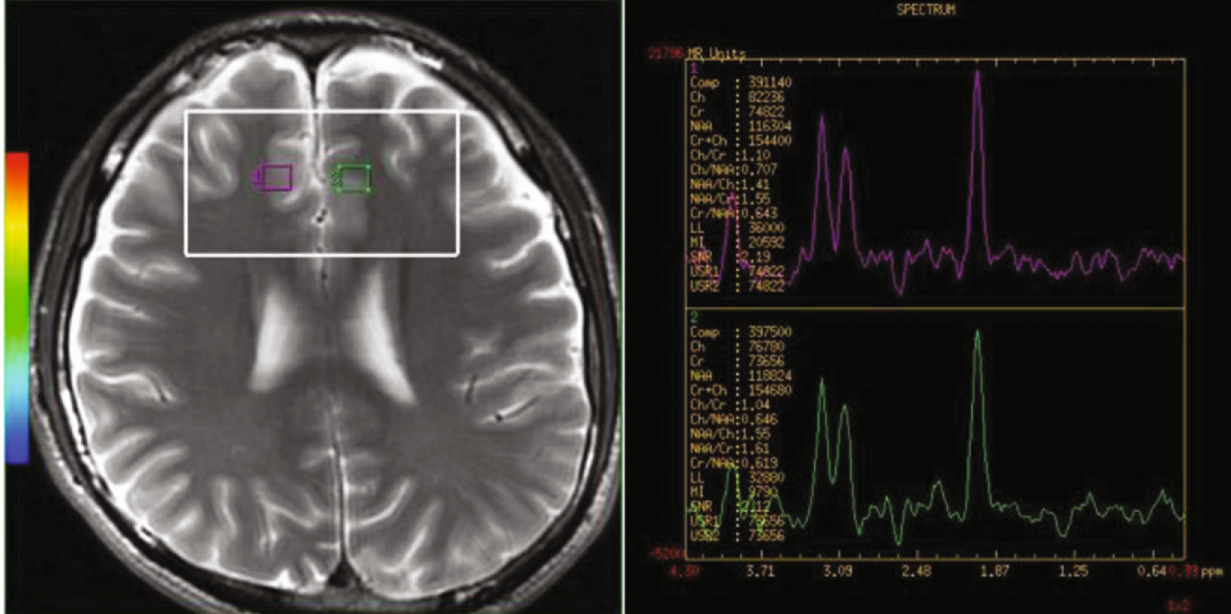
Figure 1: MRI showing the location of MRS of a VOI placed in the prefrontal cortex, with 1 H-MRS in the bilateral prefrontal cortex. The large white box shows the VOIx for MRS acquisition, and the small ones depict individual VOIs for spectral analysis. MRI: magnetic resonance imaging; MRS: magnetic resonance spectroscopy; VOI: volume of interest; 1 H-MRS: proton magnetic resonance spectroscopy; NAA: N-acetylaspartate; Cho: choline; Cr: creatine.